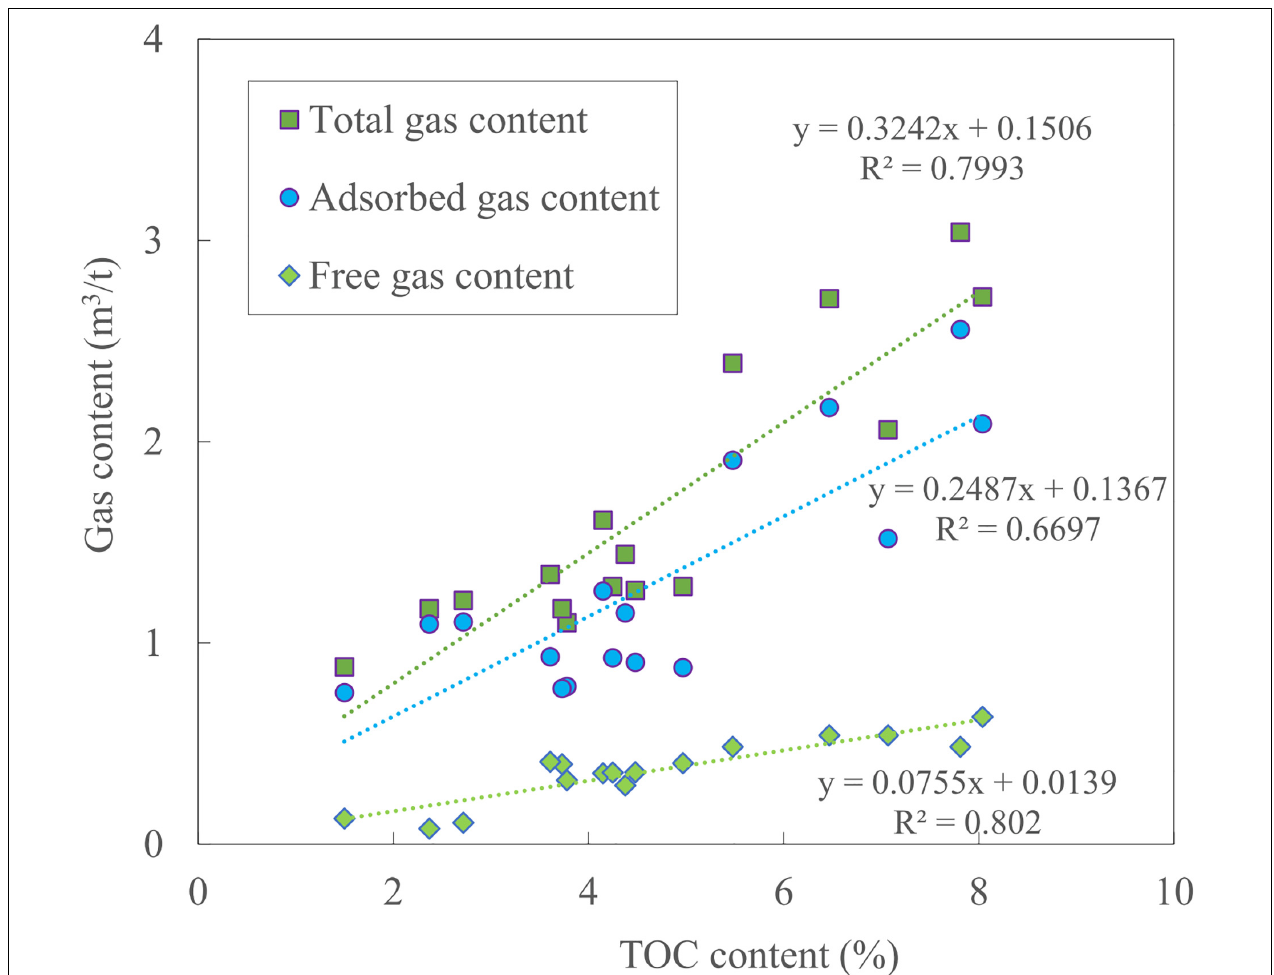
FIGURE 10 | Correlations of TOC with free, adsorbed, and total gasses for the studied shale samples. Their positive correlations indicate that TOC directly controls the gas-bearing property, so the adsorbed and free gas contents in the OM and IM pores could be determined from their linear regression equations.